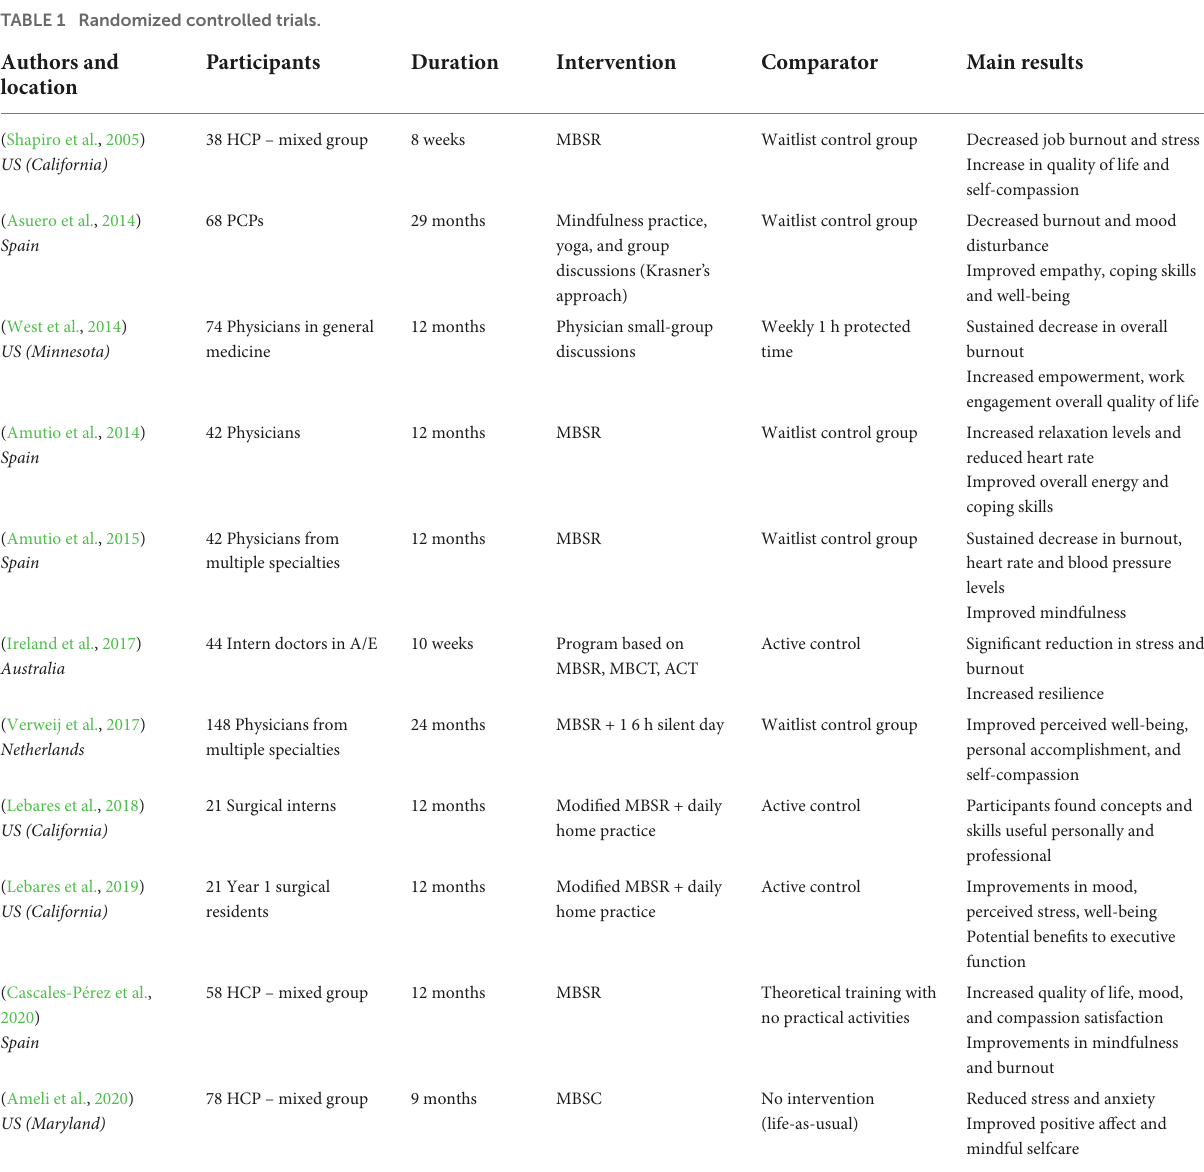
TABLE 1 Randomized controlled